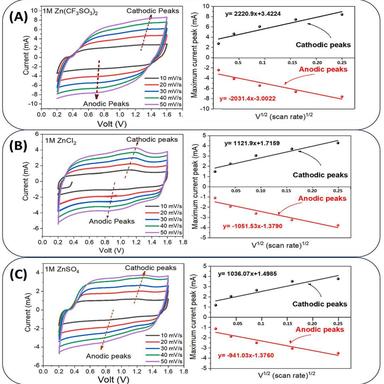
CV voltammograms at different scan rates and corresponding straight-line plots of Randles Sevcik equation of hemp-based activated carbon material in (A) ZTFMS (B) ZnCl2 and (C) ZnSO4 aqueous electrolytes containing 1 M concentration of Zn ions.